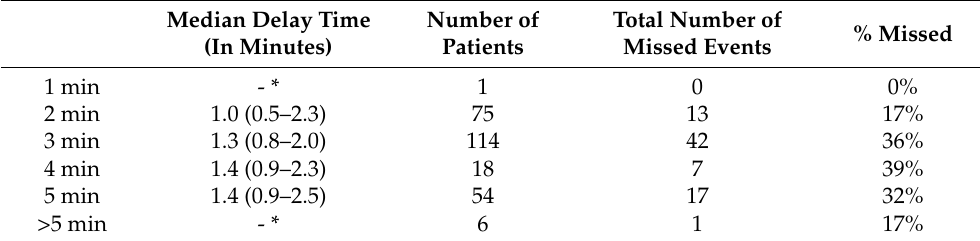
Table 3. Exploratory analyses. Missed events and delay times per NIBP-arm